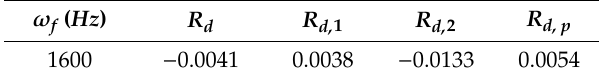
Table 3. Di ff erent real part of